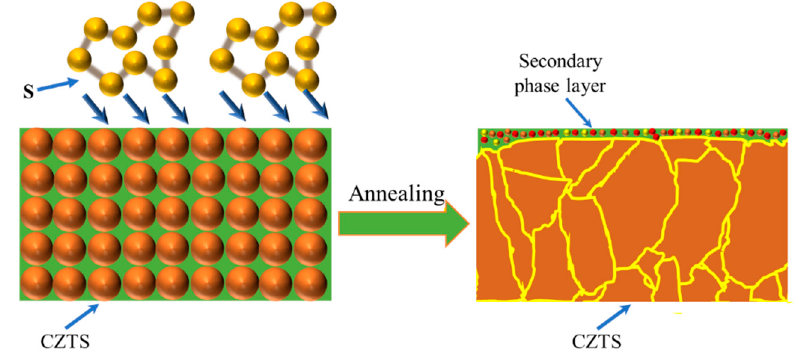
Figure 10. Schematic of the CZTS growth process and formation of secondary phases.